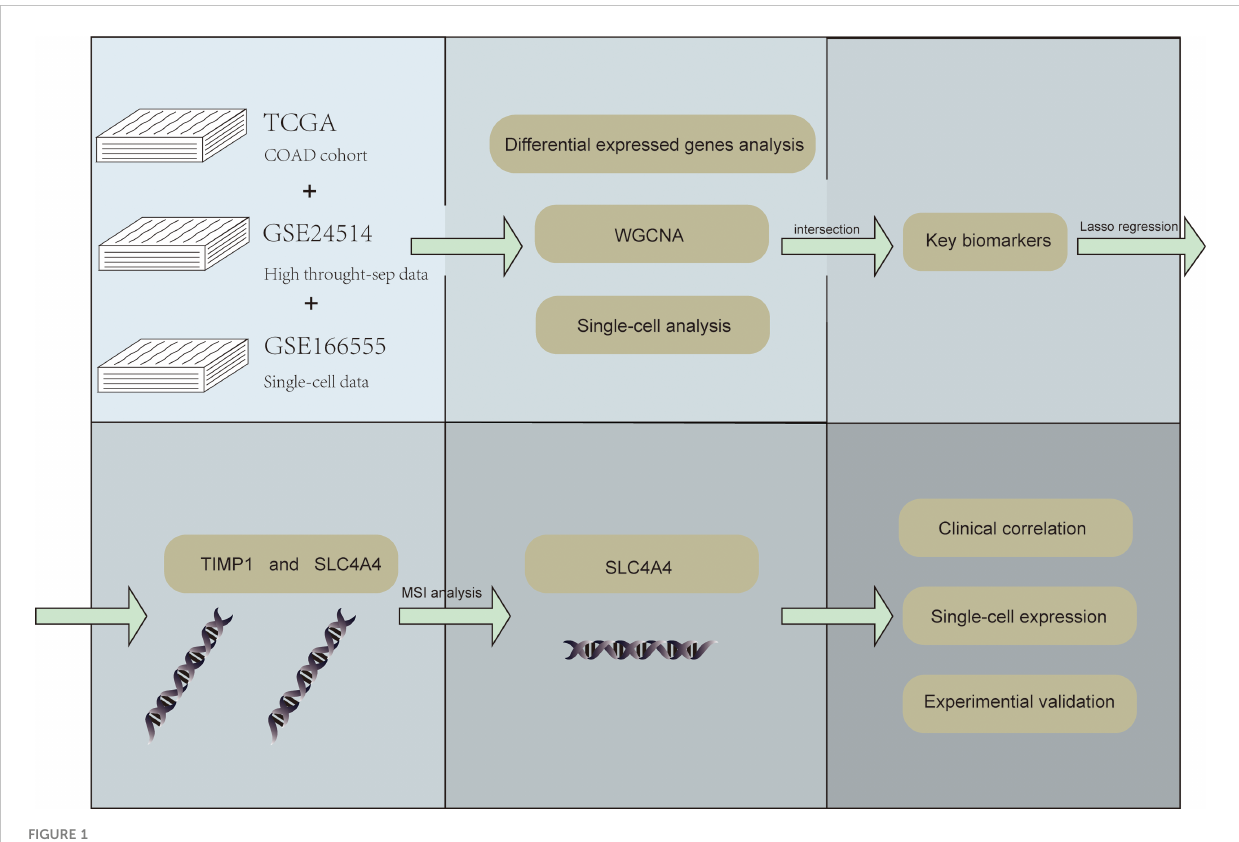
FIGURE 1 The fl ow